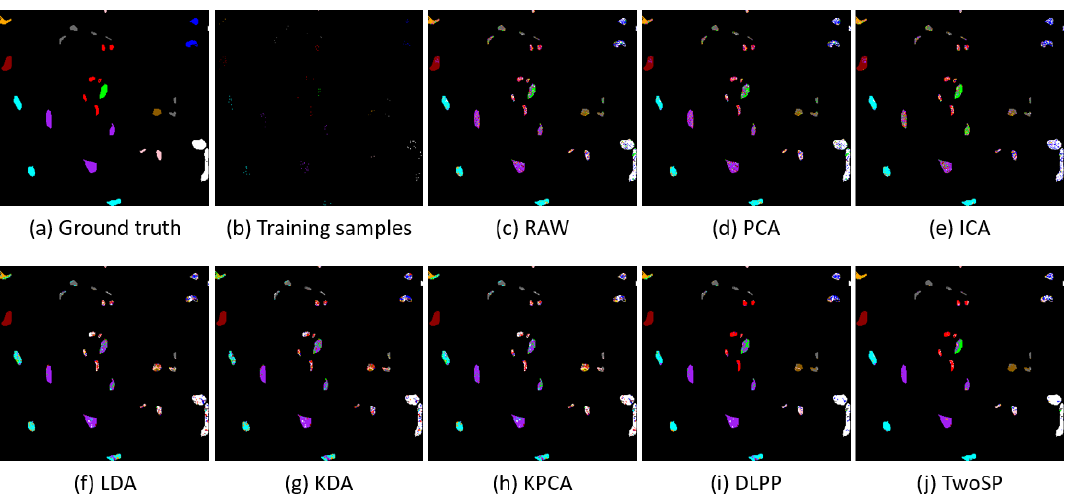
Figure 2. Classification maps (cropped to a size of 290 × 310) for the KSC dataset with different dimensionality reduction algorithms using NN classifier. ( a ) The ground truth of the classes. ( b ) Randomly selected training samples. ( c ) Result obtained by using RAW features. ( d ) PCA. ( e ) ICA. ( f ) LDA. ( h ) KDA. ( g ) KPCA. ( i ) The proposed DLPP. ( j ) The proposed TwoSP.